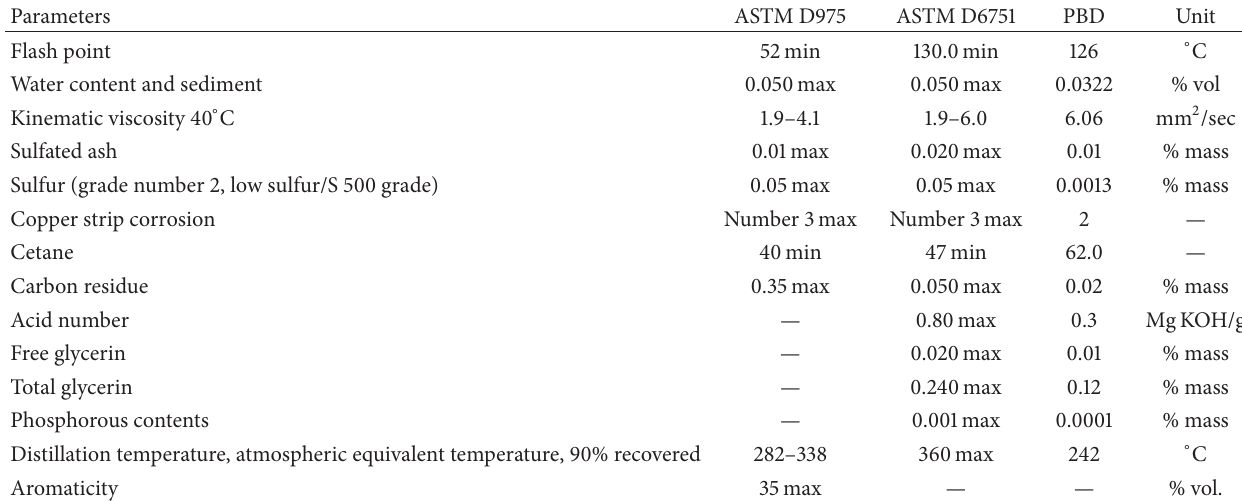
Table 2: ASTM standards for diesel, biodiesel, and fuel properties of PBD.